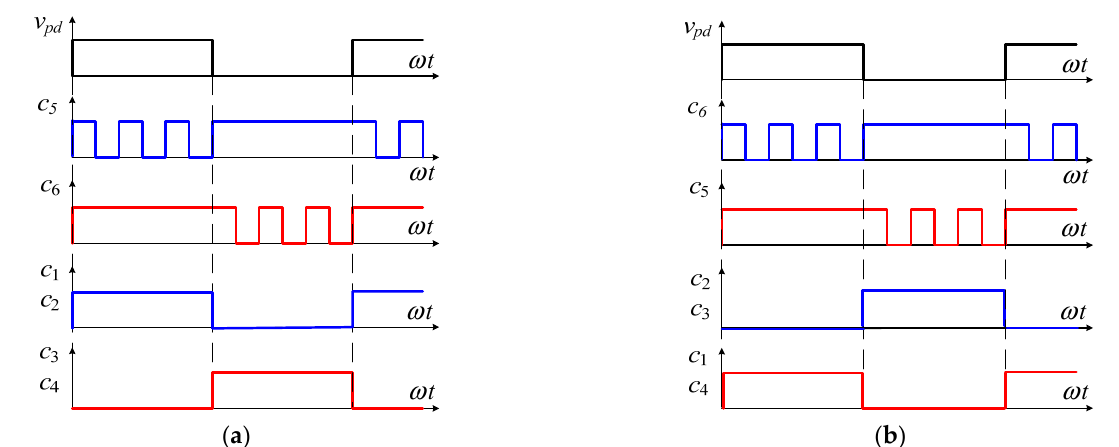
Figure 4. Generation of control signals with respect to input voltage polarity detector for voltage boost to achieve ( a ) non-inverted form of the output and ( b ) inverted form of the output.